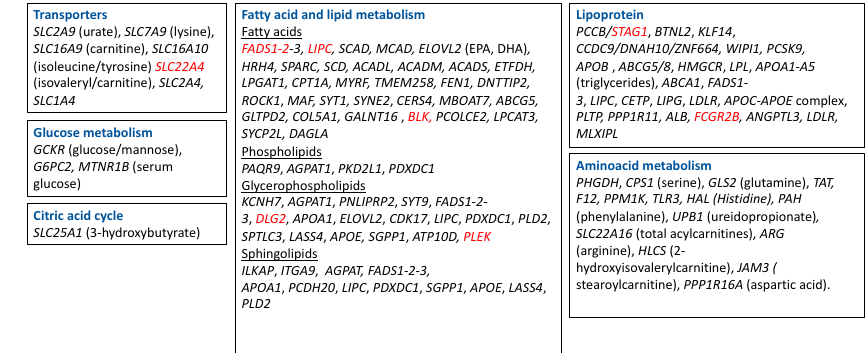
Figure 3. Metabolism-related genes described in GWAS. Highlighted in red are the genes that were found to be associated with RA. SLC2A9—Solute Carrier Family 2 Member 9; SLC7A9—Solute Carrier Family 7 Member 9; SLC16A9—Solute Carrier Family 16 Member 9; SLC16A10—Solute Carrier Family 16 Member 10; SLC22A4—Solute Carrier Family 22 Member 4; SLC22A4—Solute Carrier Family